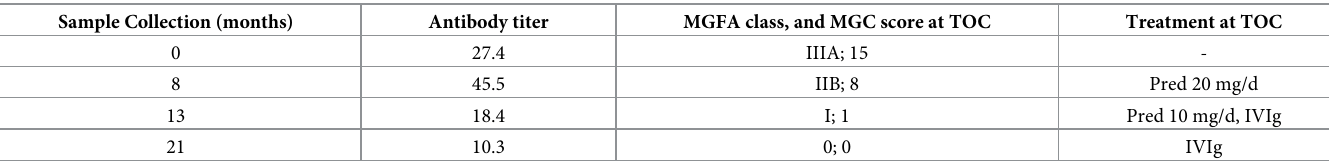
Table 3. Patient characteristics during longitudinal sample